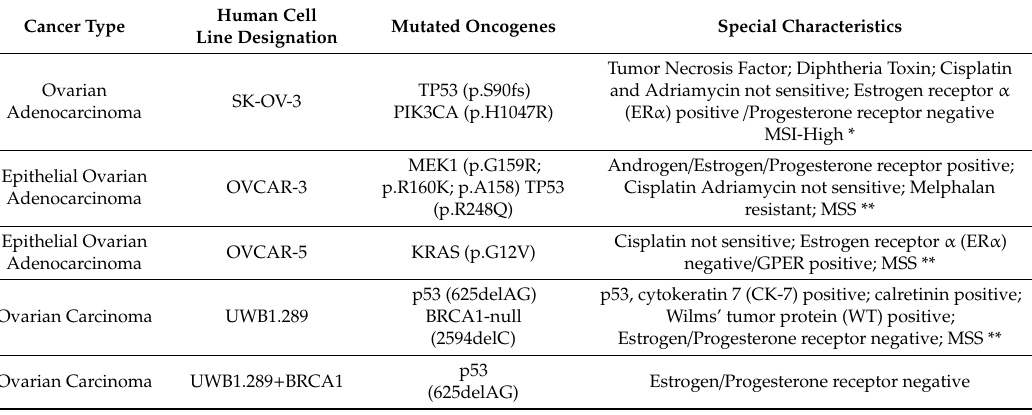
Table A8. Human ovarian cancer cell lines to be used for the in vitro analysis of the compounds biological activity.